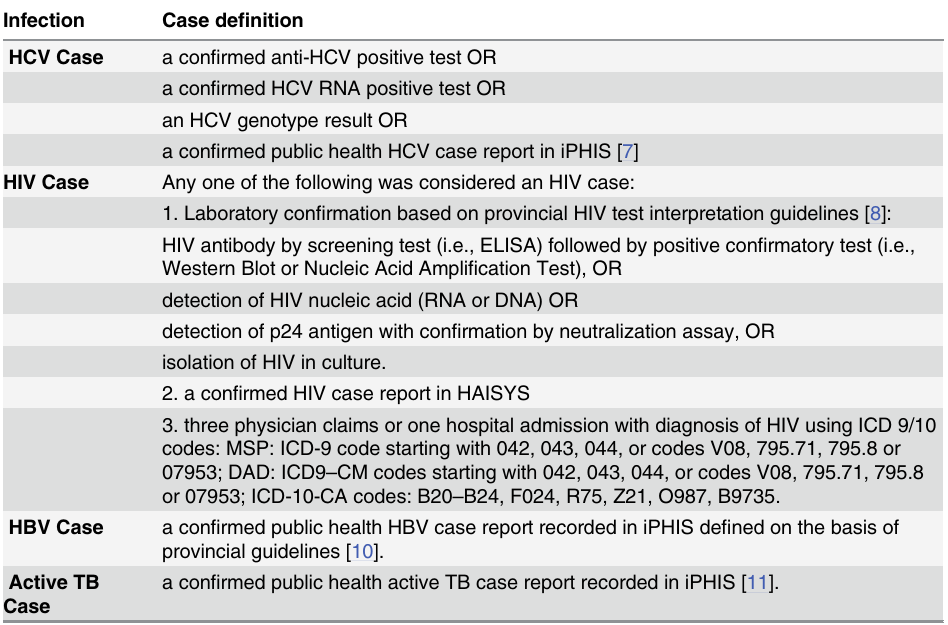
Table 1. Case definitions for HCV, HBV, HIV and active